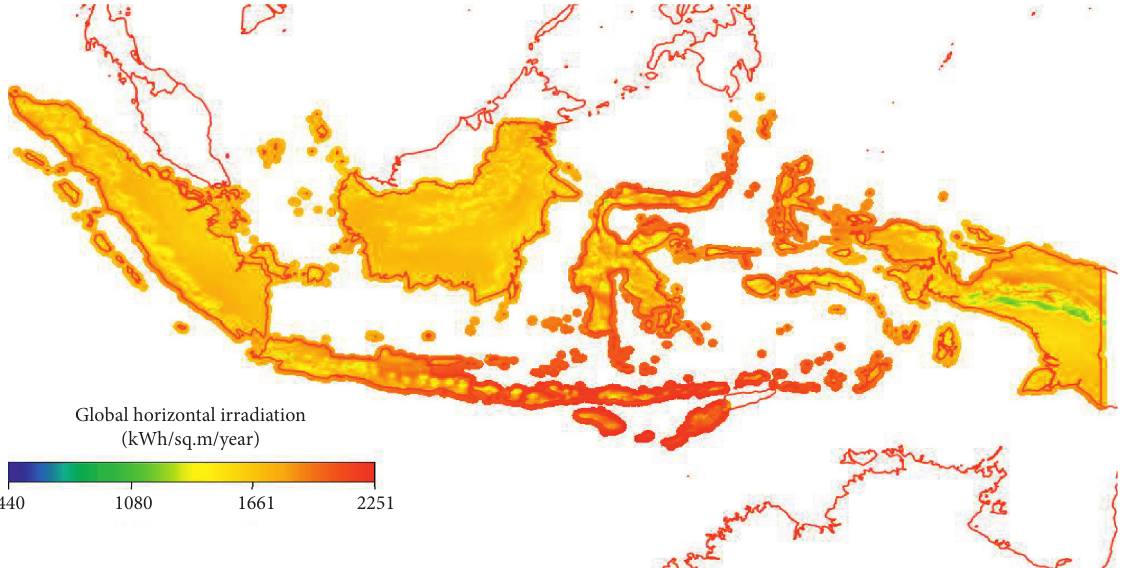
Figure 1: SolarGIS long-term mean surface radiation in Indonesia. Table 1: The general summary of open-source satellite-derived solar resource database for Indonesia.